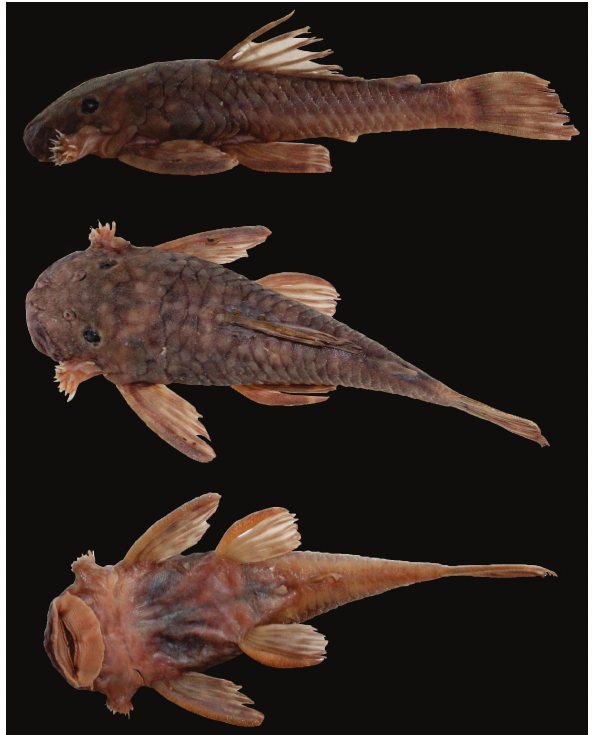
Figure 1. Ancistrus multispinis (95.8 mm standard length and 9.4 g weight) in three views: lateral, upper and